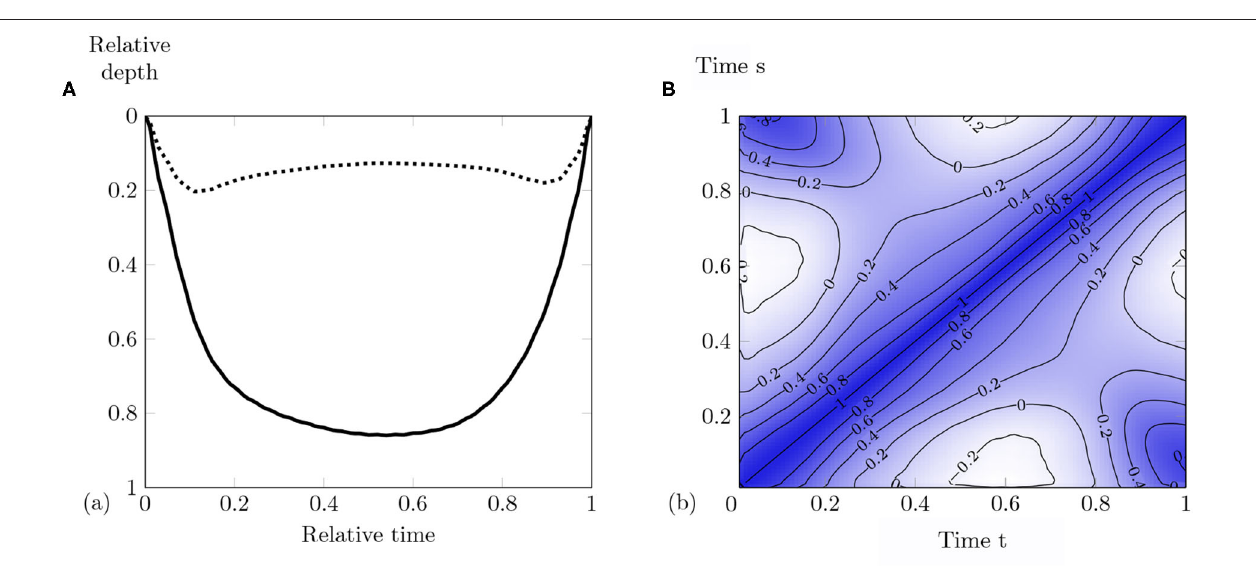
time with high variability [panel (B)]. Finally, the third axis explaining 13% of the variance (not shown here) differentiates dives according to their skewness. Skewed right means that the maximum depth of the dive is on the right (i.e., near the end of the dive), and skewed left means that the maximum is on the left (i.e., near the beginning of the dive). Thanks to the functional PCA, each dive can be reconstituted as a linear combination of these three independent previous factors (U or V shape,